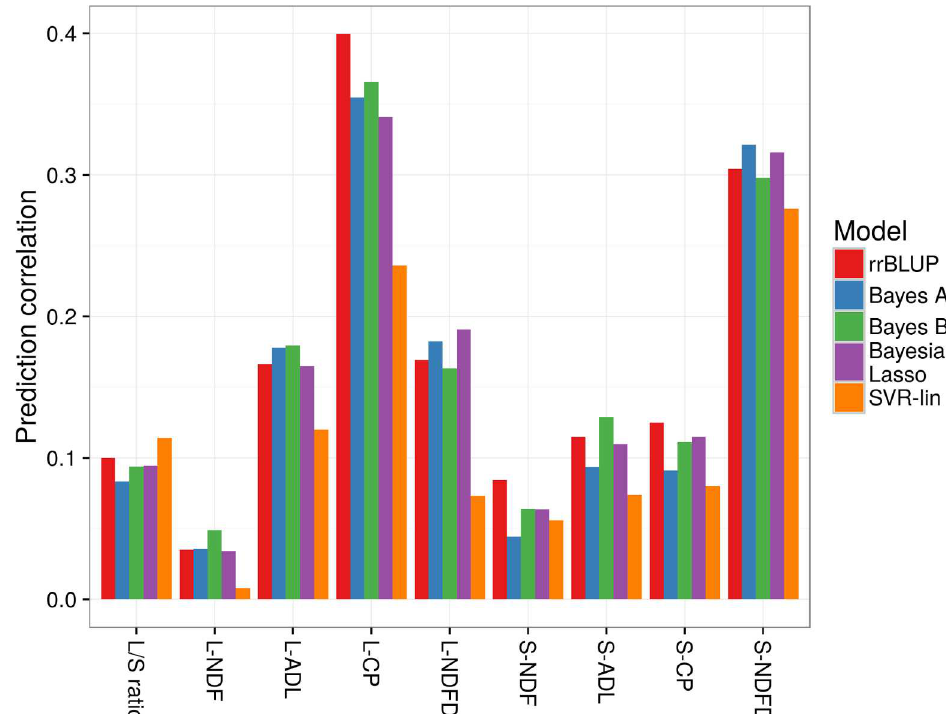
Fig 3. Accuracy of genome-enabled predictions for alfalfa forage quality traits based on five regression models. Pearson’s correlationbetweenactual and predictedphenotypes (averageof 500 repetitionsof 10-fold cross validation).L/S ratio, leaf-to-stem ratio; L-NDF, leaf neutral detergentfiber; L-ADL, leaf acid detergentlignin; L-CP, leaf crude protein; L-NDFD, leaf in vitro NDF digestibilityat 24 hours; S-NDF, stem neutral detergentfiber; S-ADL, stem acid detergent lignin; S-CP, stem crude protein; S-NDFD, stem in vitro NDF digestibilityat 24 hours.